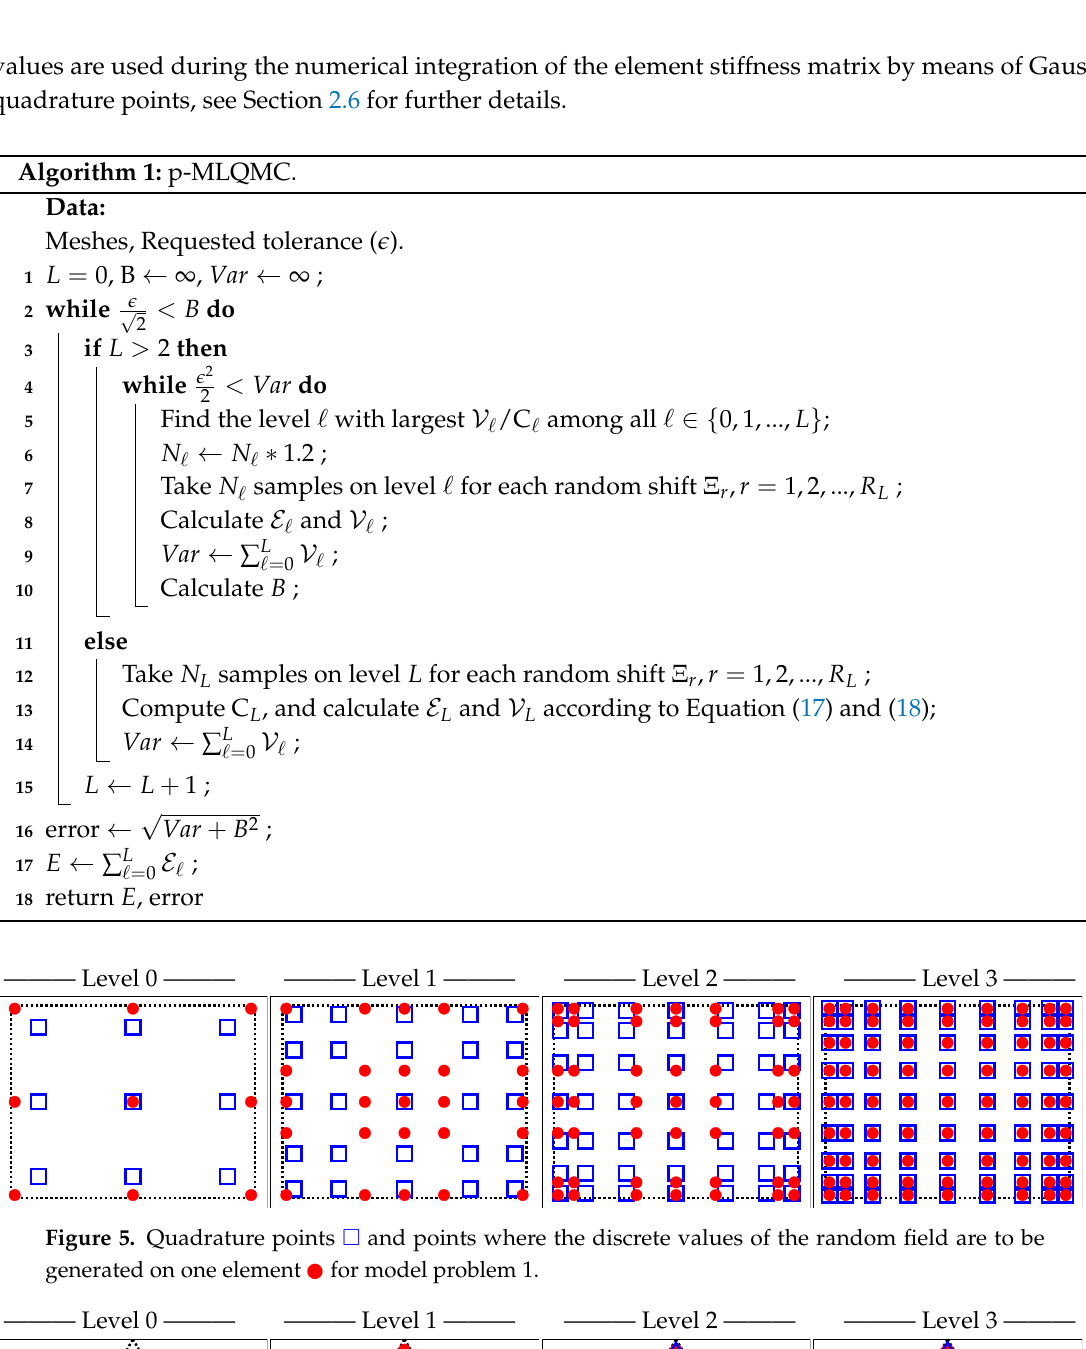
and points where the discrete values of the random field are to be (cid:52) for model problem (cid:32)